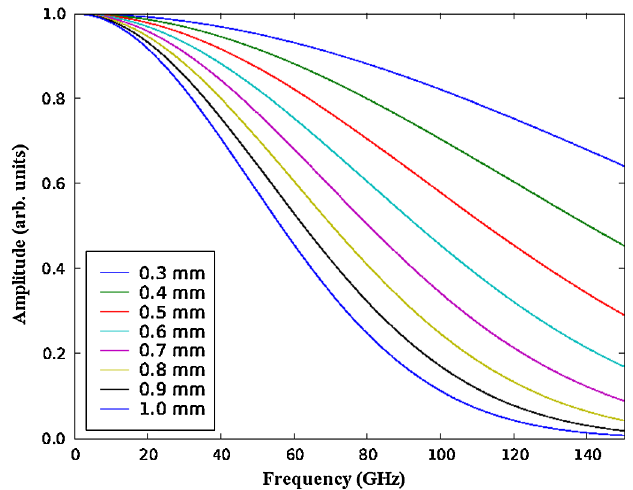
FIG. 5. (Color) Radiation spectra calculated for Gaussian bunches of various lengths (indicated in the legend).